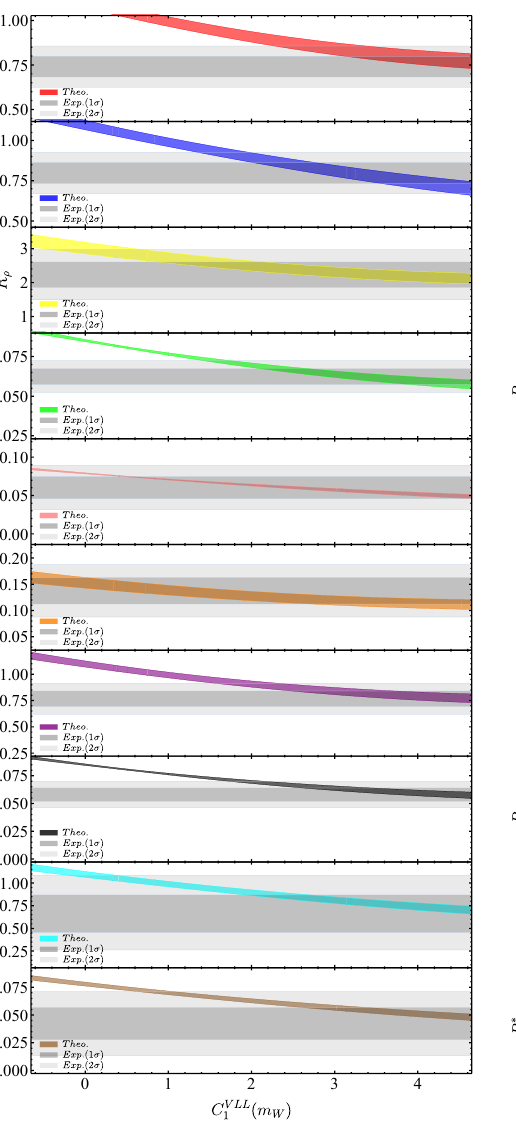
Figure 11 . Constraints on the NP Wilson coefficients C V LL